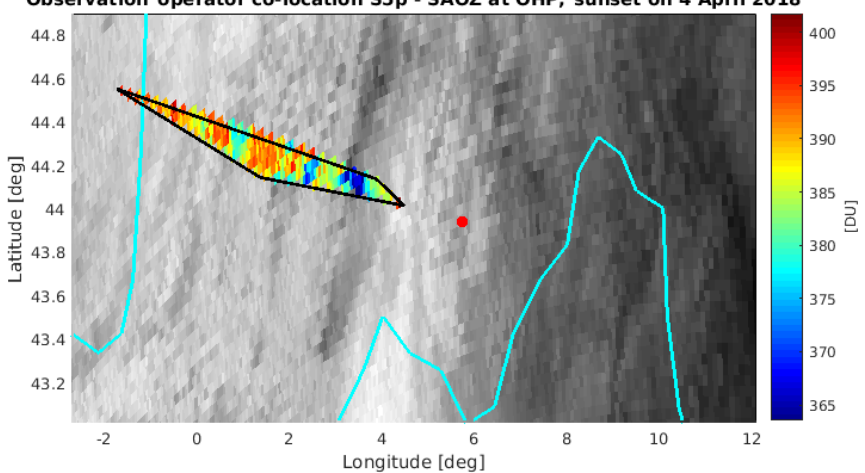
Figure 5. Illustration of the co-location procedure for TROPOMI versus SAOZ measurements, in this case for a sunset SAOZ measurement at the Observatoire de Haute Provence (France) in local spring. The red disk marks the instrument location. The black polygon is the observation operator, i.e., the parameterized extent of the actual twilight measurement sensitivity. The gray background is the TOC measured in a temporally co-located TROPOMI orbit (no. 2456) and the colored pixels are those that fall within the observation operator, i.e., those that are averaged before being compared to the SAOZ